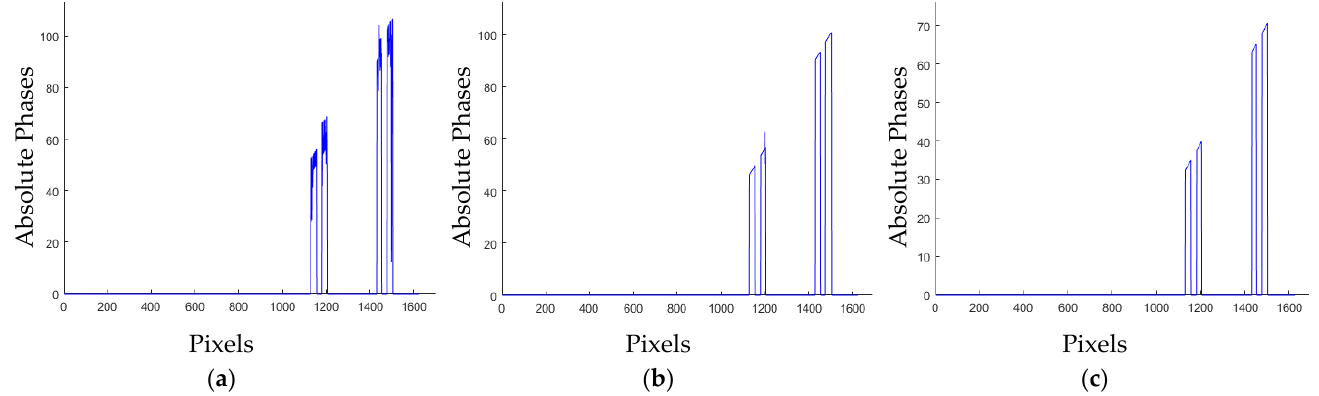
Figure 7. Absolute phase of U-card acquired by different methods. Traditional method ( a ). Method of [15] ( b ). Method of this paper ( c ).